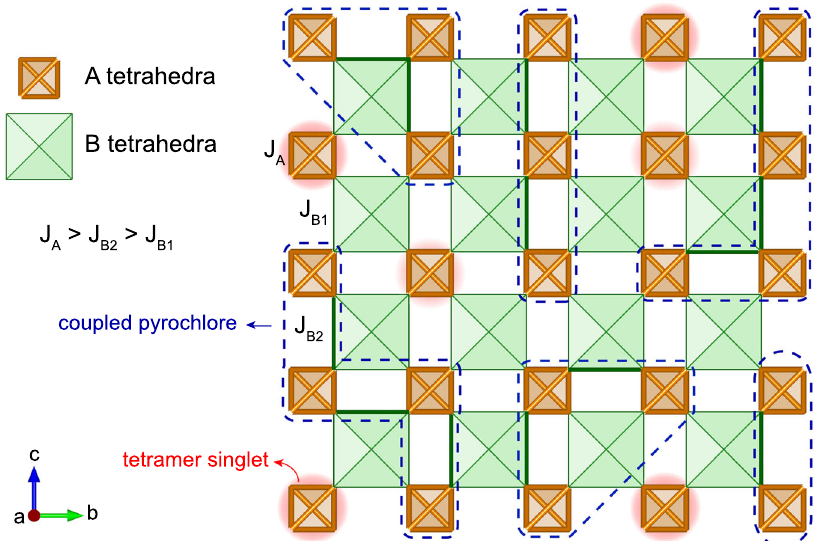
Fig. 6 Illustration of the emergent magnetic lattices in a bond-disordered breathing pyrochlore. Schematics of single-A tetrahedra (orange squares) and three different B tetrahedra (green squares) created by the Ga-for-In substitution. The thick and thin green lines denote J B2 and J B1 , respectively. Given the energy hierarchy of magnetic interactions tetramer singlets (red shaded circle) and diluted pyrochlore lattices (blue dashed